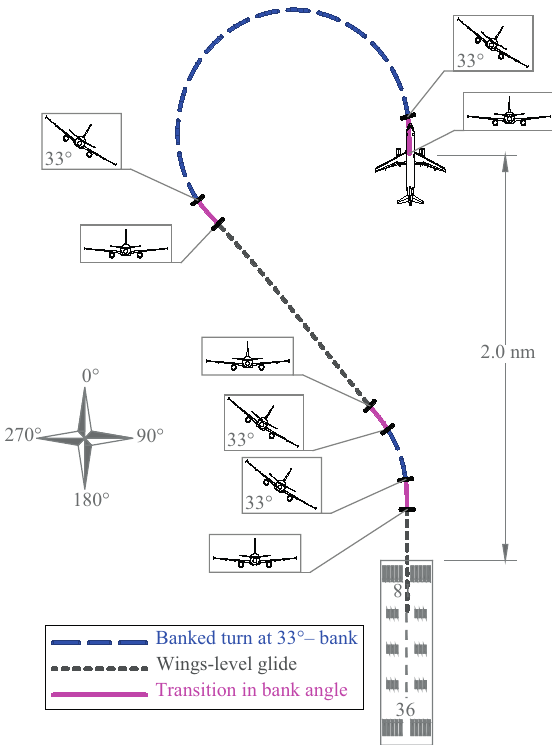
Fig. 4. Ground tracks for the optimum engines-out landing trajectory at 160 KCAS (aircraft gross weight = 70.0 tons, no wind, standard day conditions)